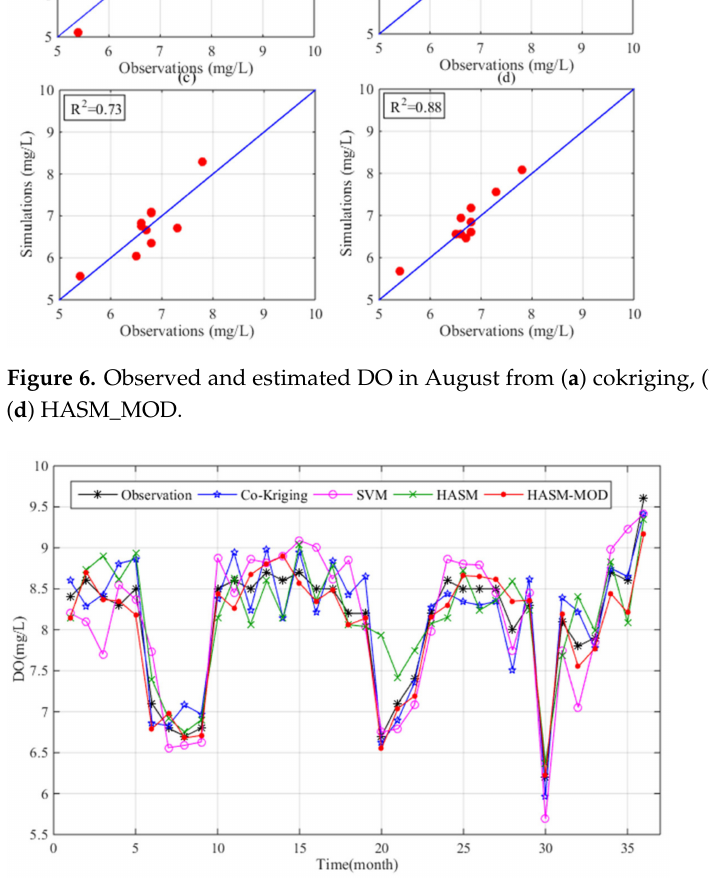
Figure 7. Comparison of the results of different methods with the observations at Sanshan station from January 2015 to December 2017.